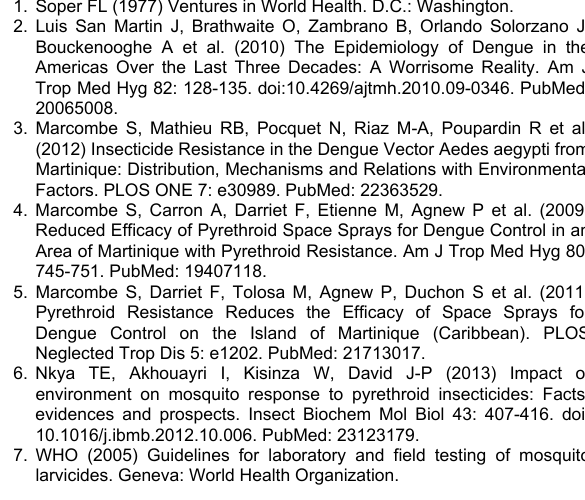
Table S4. Genes up to 500 kb each direction from the